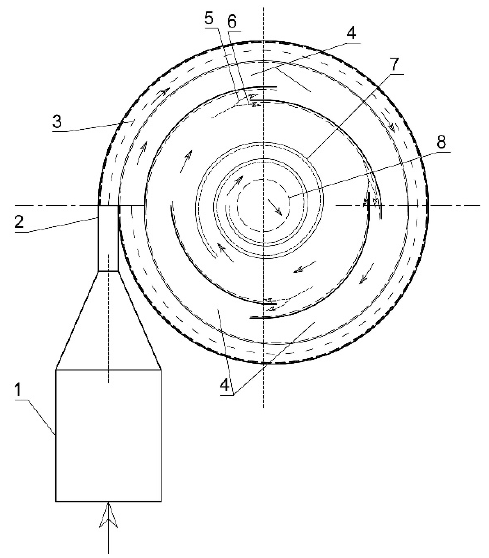
Figure 1. Schematic diagram of an electro cyclone-filter equipped with (1) inflow pipe, (2) inlet to the cyclone channel, (3) centrifugal settling zone, (4) multi-channel cyclone-filter zones bounded by curvilinear elements, (5) peripheral gas flow, (6) transit gas flow, (7) electrostatic deposition zone, (8) cleaned air duct.